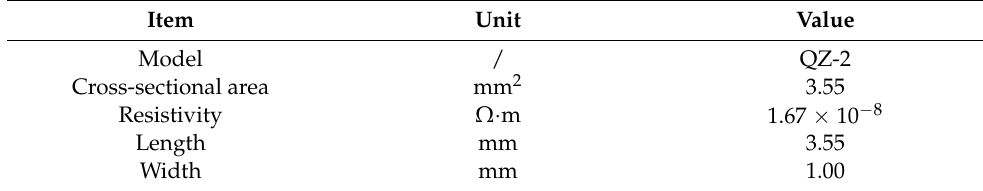
Table 1. Wire Specific Parameters.